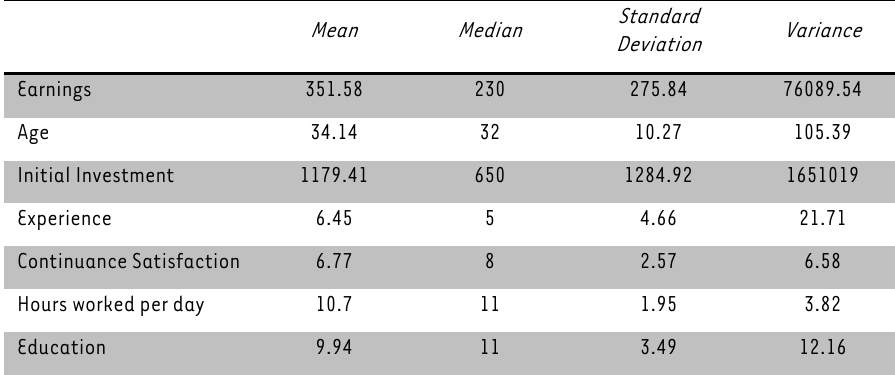
TABLE 2: Mean, Median, Standard Deviation and Variance